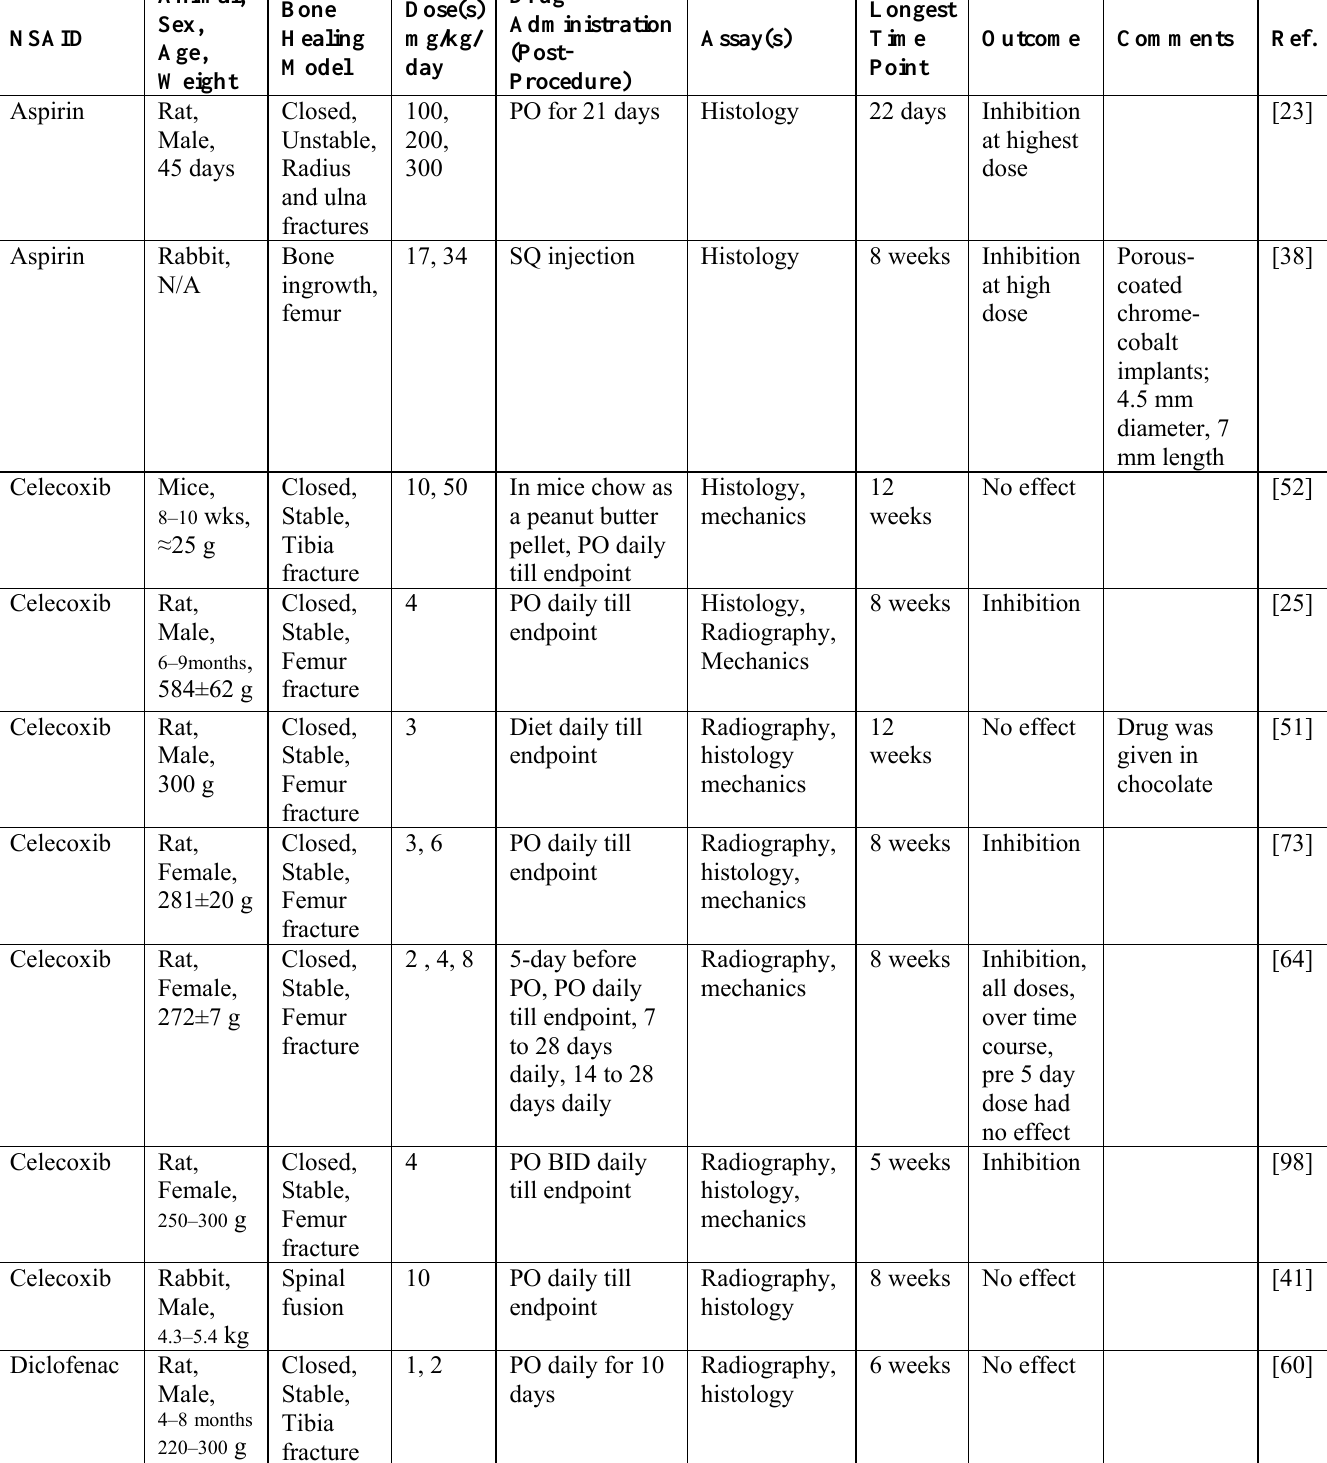
Table 1. NSAID effects on bone healing: animal